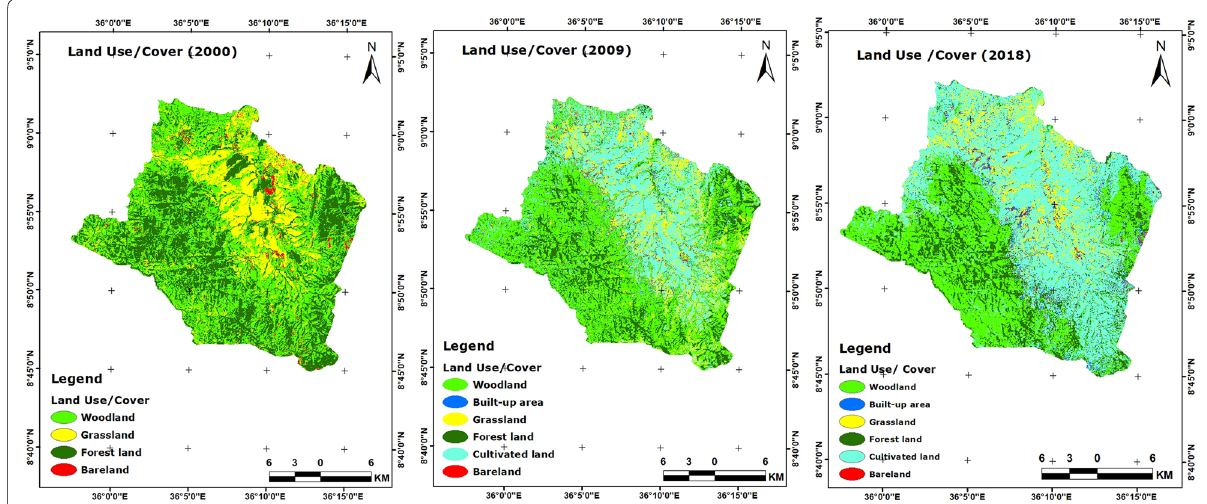
Fig. 3 Land use/cover maps of Chewaka district in 2000, 2009 and